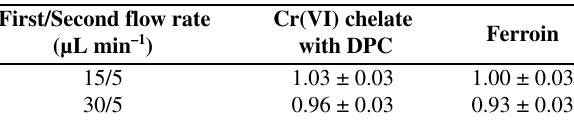
Table 1. The ratios of slopes derived from dependences of thermal- lens signal on the excitation power (Fig. 2) calculated for flow rate pairs of 15 and 5, 30 and 5, and 30 and 15 μL min –1 for pre-synthe- sized Cr(VI)–DPC chelate and ferroin ( n = 3, P = 0.95) First/Second flow